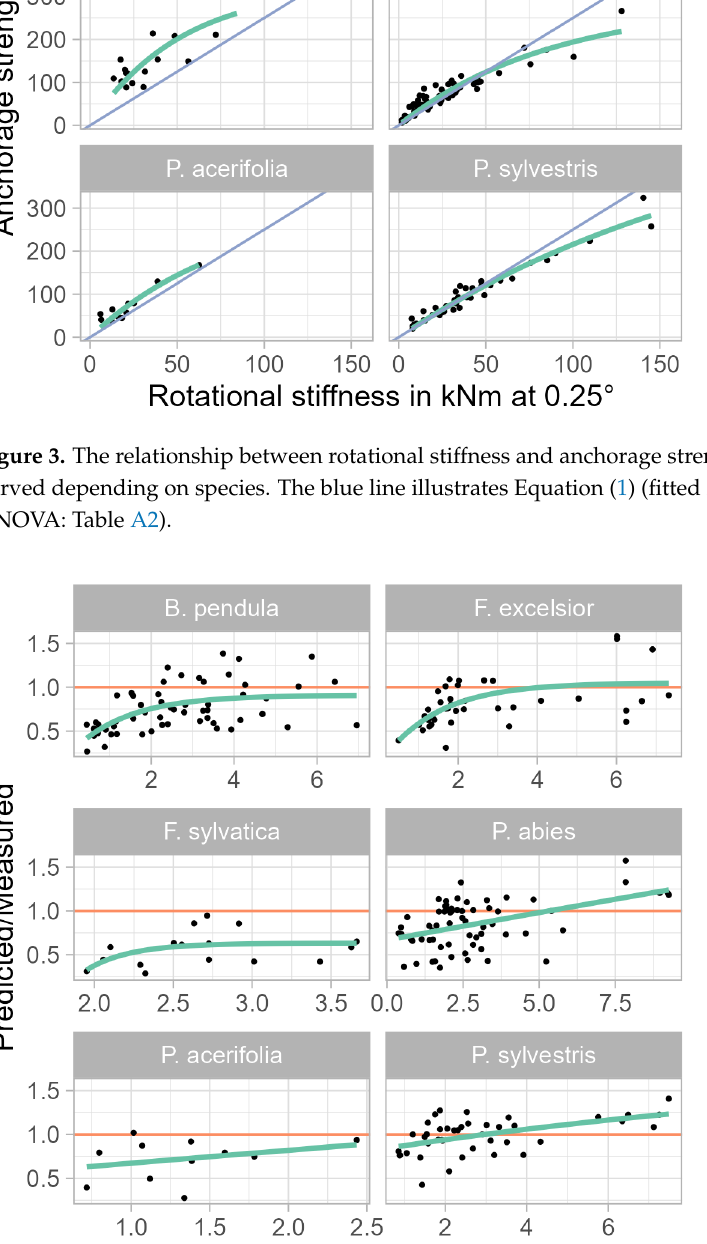
− a Size + b , ANOVA: Table = y 0 e M a